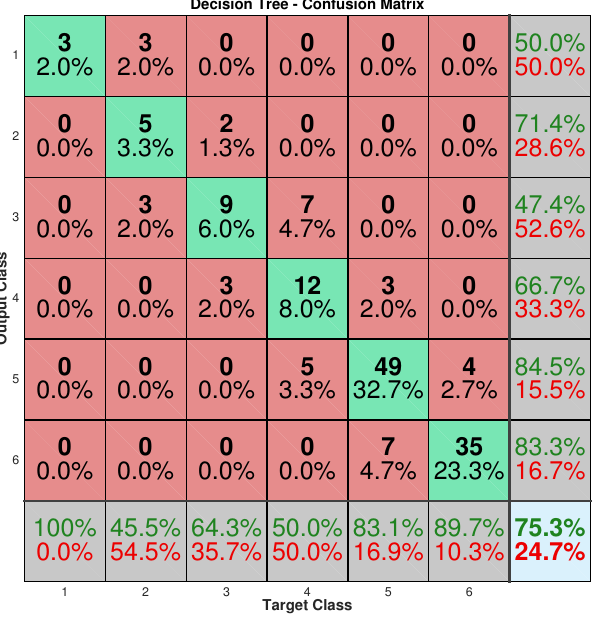
Figure 8. Confusion Matrix of the Decision Tree